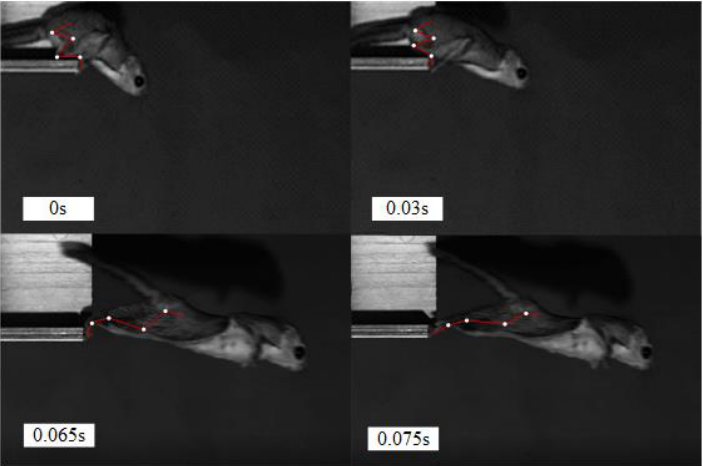
Figure 3. Motional sequence of jumping for gliding of the flying squirrel. The white dots are the markers on the joints of the hind limb, and the red lines denote the linkages between the joints.